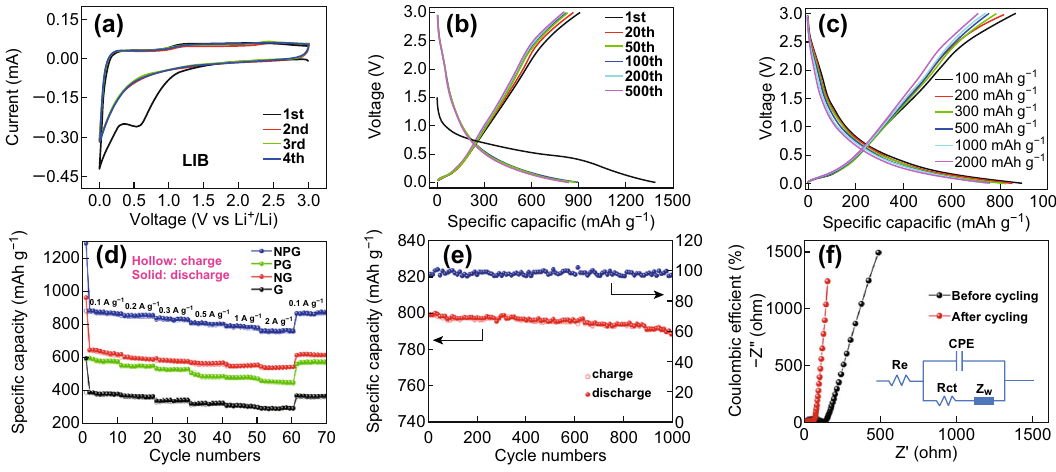
Fig. 4 a CV curves of the NPG sample at a scanning rate of 0.1 mV s −1 . b Galvanostatic curves of NPG at a current density of 100 mA g −1 . c Typical galvanostatic curves of the NPG electrode at different current densities. d Rate capabilities of G, NG, PG, and NPG electrodes at differ- ent current densities. e Cycling stability of the NPG electrode at the current density of 1000 mA g −1 . f Nyquist plots of